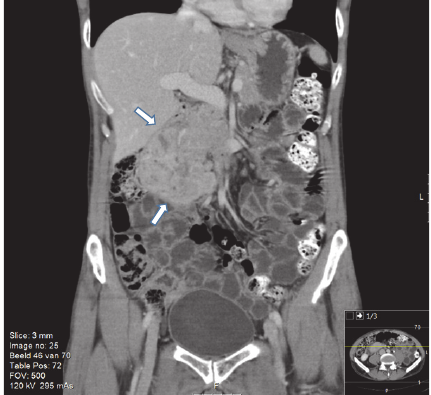
Figure 1: Axial CT view showing a large mass of approximately 8cm in diameter, near the proximal duodenum. Oral and IV contrast were given.